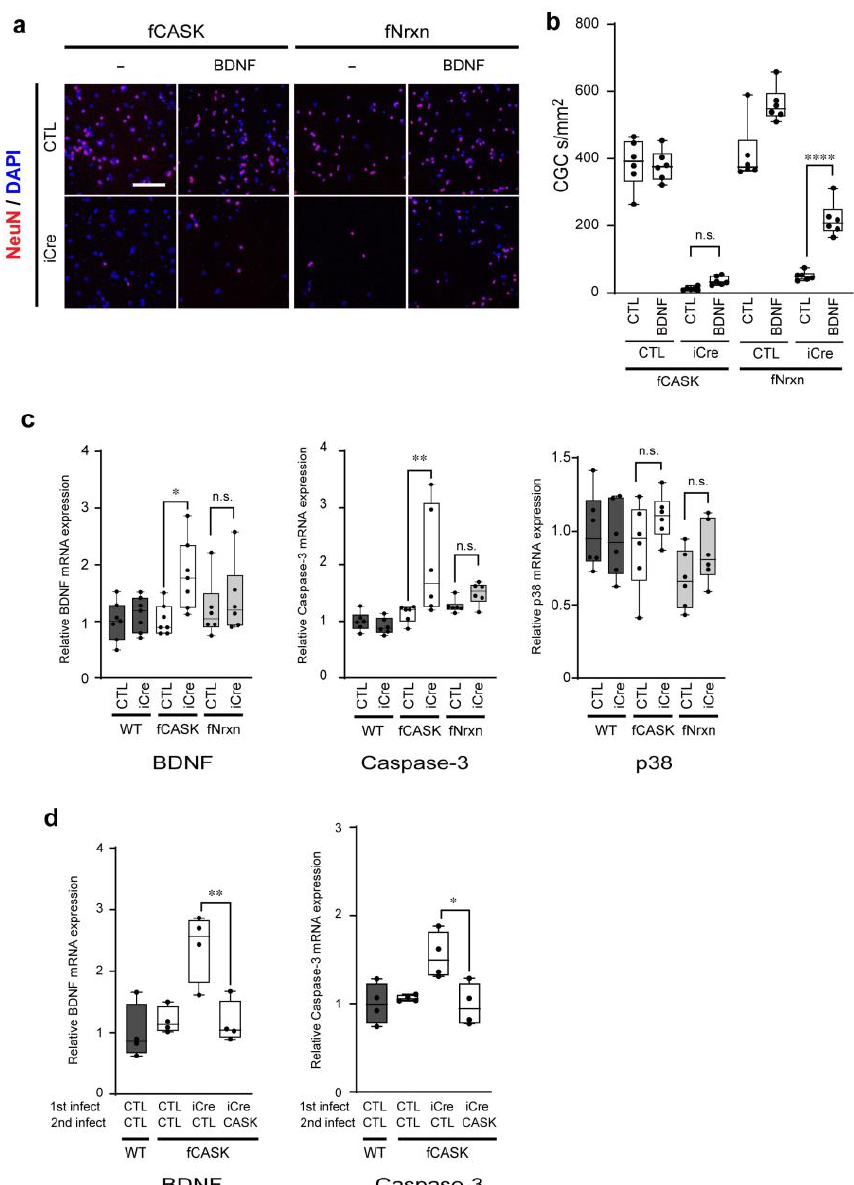
Figure 3. BDNF does not rescue cell survival defects in cultured CASK KO CG cells. ( a ) Cultured